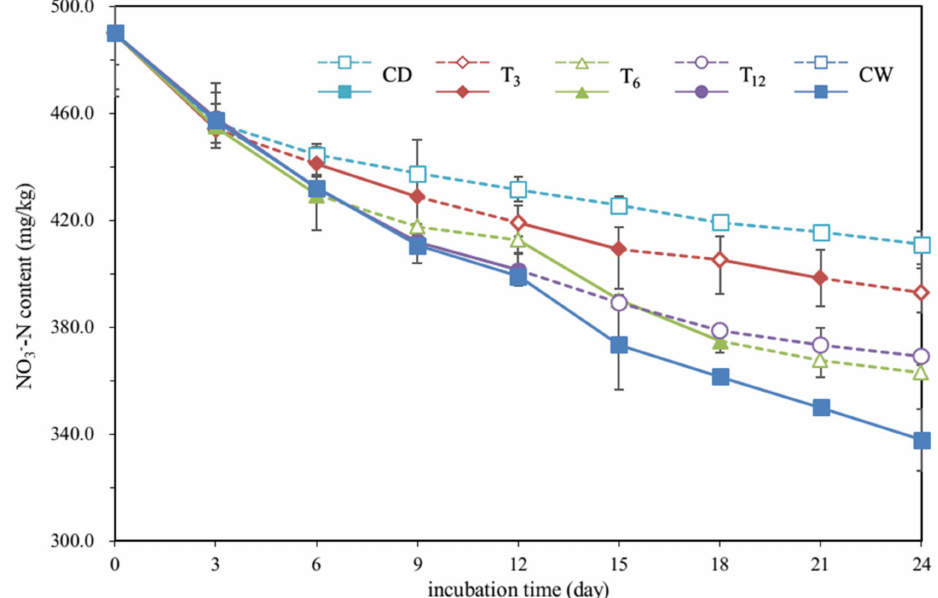
Figure 2. The dynamic of NO 3 − -N content in different treatments. The solid and dotted lines represent the rewetting and drying period, respectively. The vertical bars refer to one standard deviation ( n =